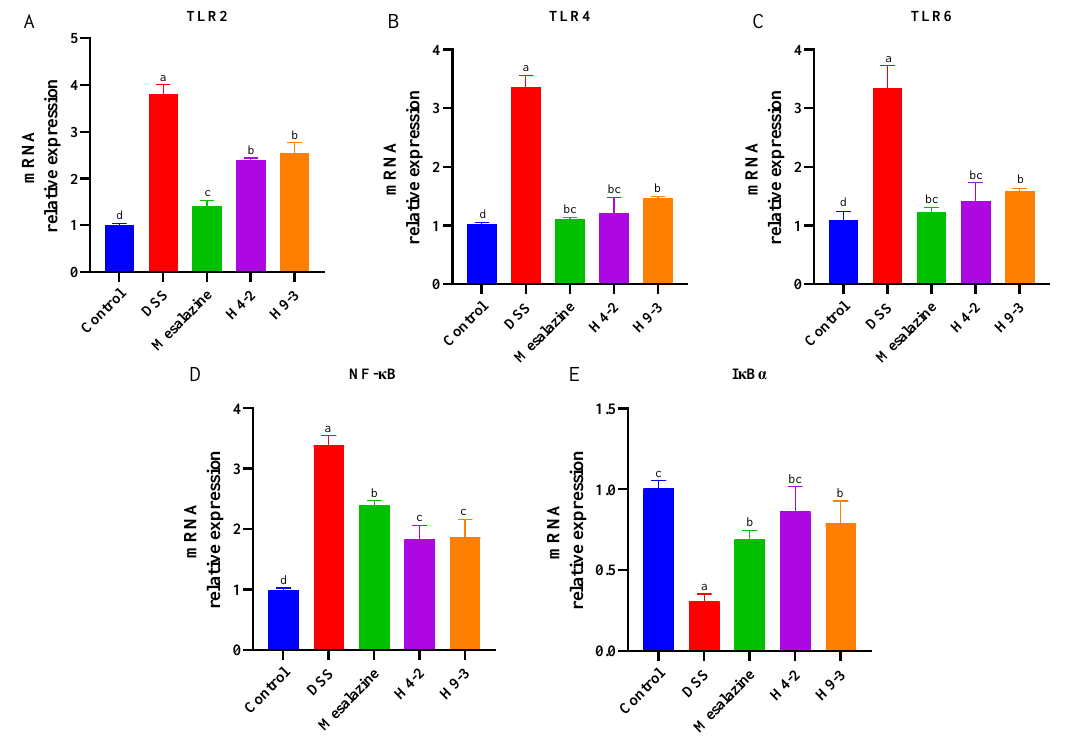
Figure 7. The mRNA expression changes of TLR-2 ( A ), TLR-4 ( B ), TLR-6 ( C ), NF- κ B ( D ) and I κ B α ( E ) in mice colon tissue after intervention with B. breve . Different lowercase letters (a, b, c, d) above the columns indicate significant differences ( p < 0.05), and the same superscript letters indicate that the differences between the values are not statistically significant ( p > 0.05).